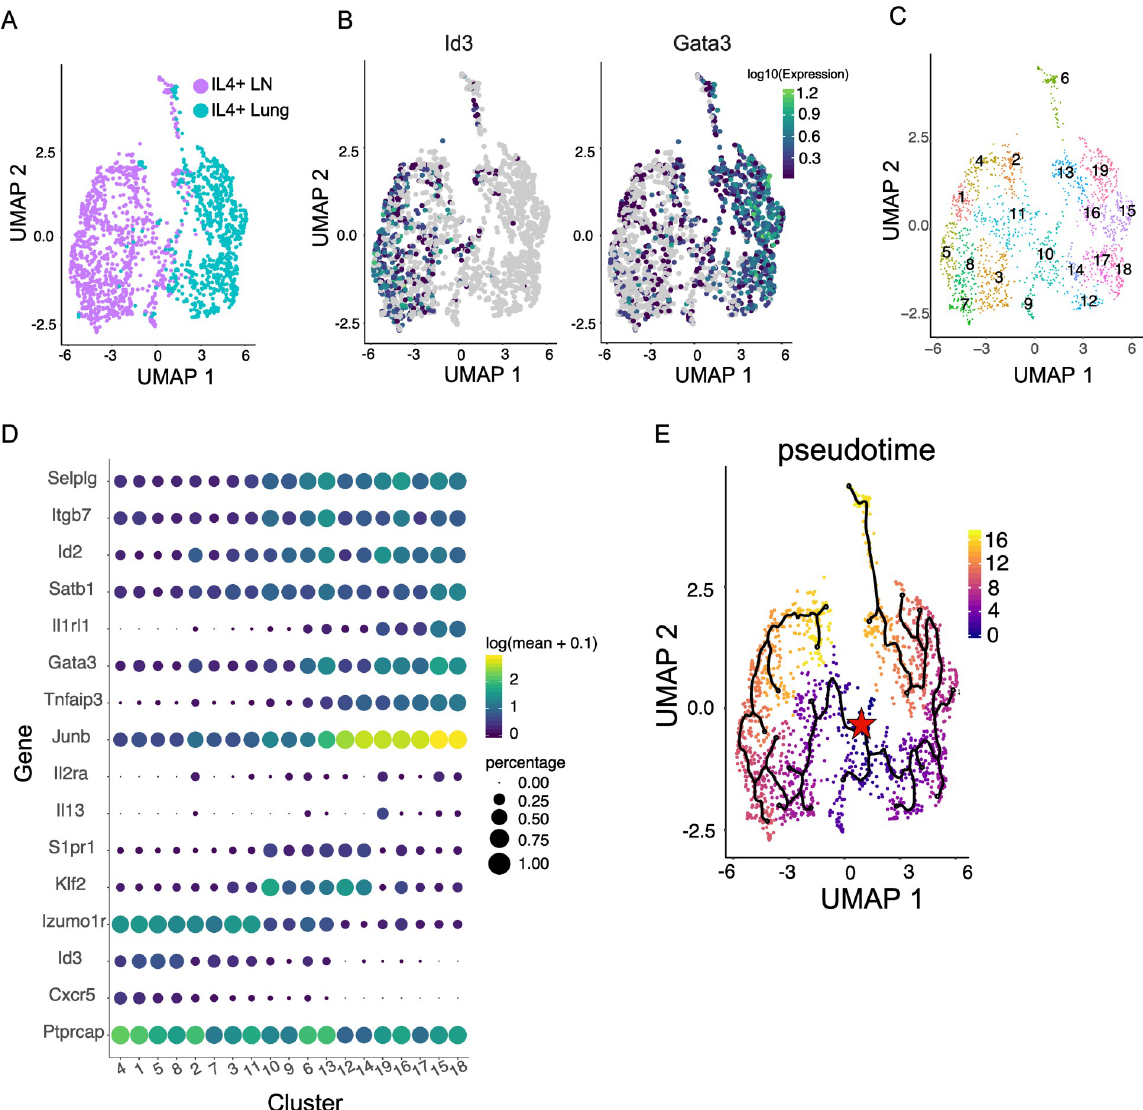
Fig 8. Trajectory analysis of IL-4 + T cells in the lymph node and lung after helminth infection. IL-4 + CD4 + T cells from the lung and mediastinal lymph nodes were harvested and processed for single-cell RNA-seq analysis. Trajectory analysis was performed using Monocle 3. (A) UMAP of IL-4 + CD4 + T cells in the mediastinal lymph node (purple) and lung (aqua). (B) UMAP overlaid with the relative gene expression of Id3 (left) and Gata3 (right) in single cells. (C) IL-4 + CD4 + T cells from the mediastinal lymph node and lung were clustered into 19 groups based on transcriptome relatedness. (D) Relative gene expression and the percentage of cells expressing indicated gene in each cluster as outlined in (C). (E) Pseudotime trajectory analysis starting at origin in cluster 10 (Red star). Pseudotime coloring represents an arbitrary period of time as cells progress along different branch points toward distinct cell